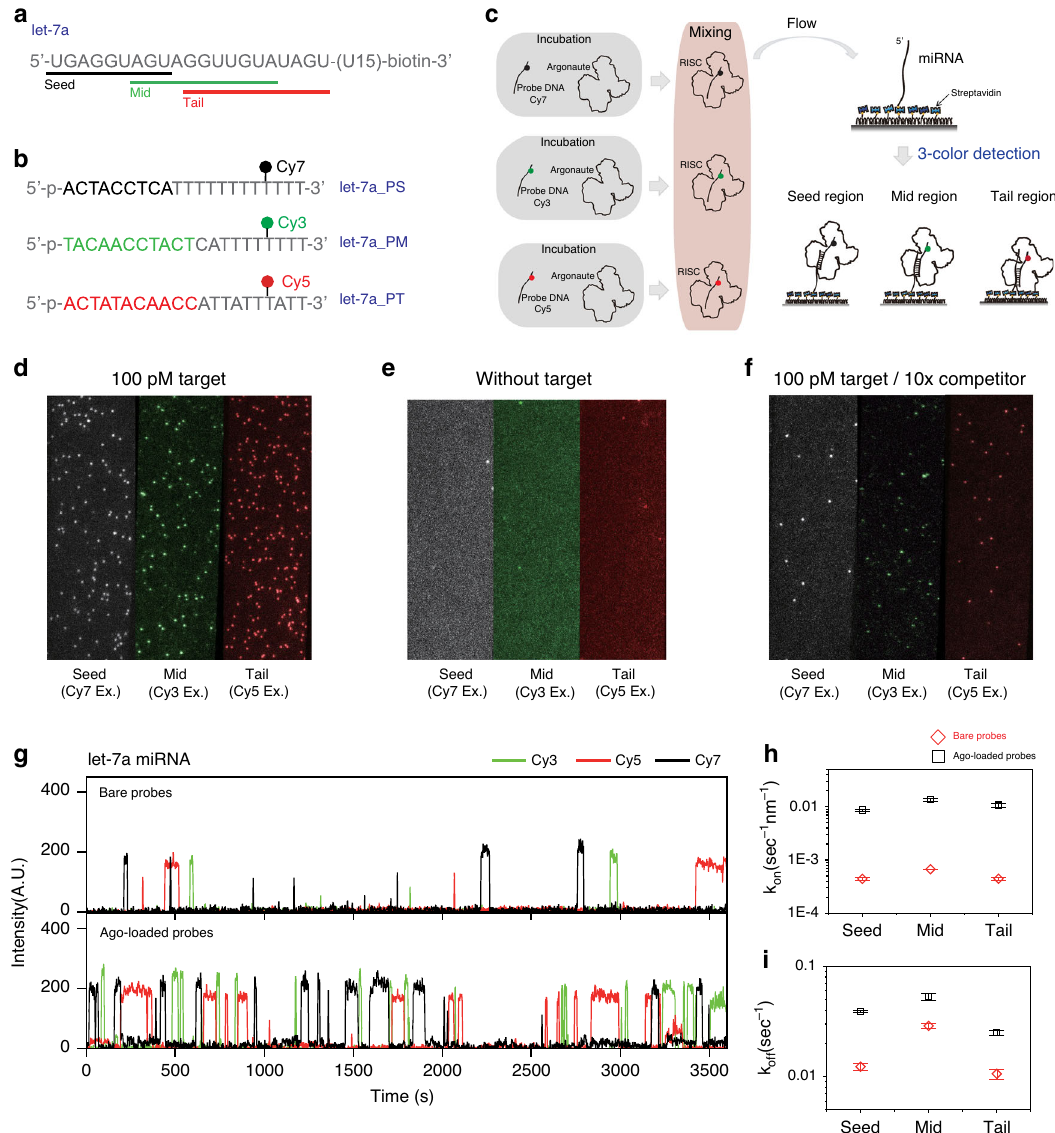
Fig. 1 miRNA detection scheme. a Design of the target RNA containing let-7a sequence on the 5 ′ -side, U15 linker on the 3 ′ -side, and biotin at the 3 ′ -end. b Design of DNA probes targeting let-7a. let-7a_PS, let-7a_PM, and let-7a_PT targeting the seed, mid, and tail regions of let-7a, respectively, are labeled with different fl uorophores as depicted. c Scheme to accelerate miRNA detection. DNA probes are loaded in Tt Ago, and their biding to